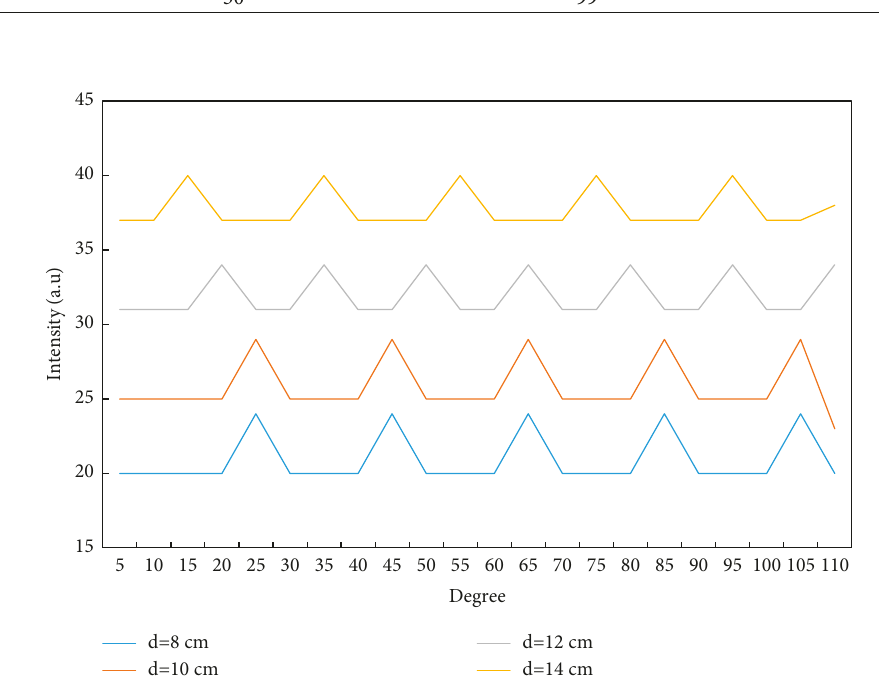
Figure 3: XRD test